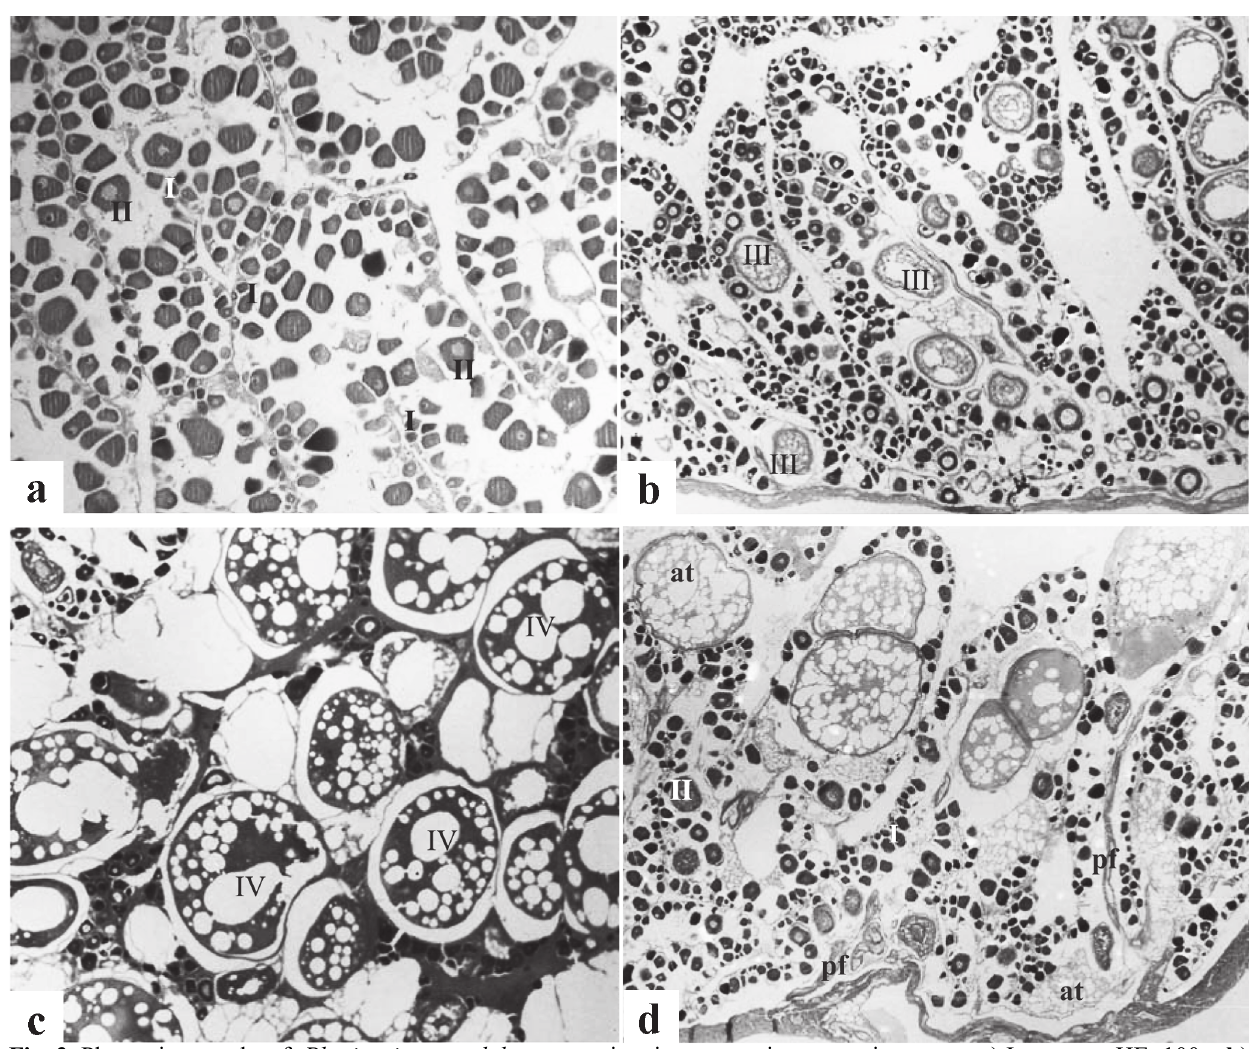
Fig. 3. Photomicrographs of Plagioscion magdalenae ovarian tissue at various maturity stages. a ) Immature, HE, 100x. b ) Maturing, HE, 100x. c ) Mature, HE, 40x. d ) Spawned/spent, HE, 40x. I. chromatin nucleolus (stage I); II. perinucleolar stage (stage II); III. cortical alveoli oocytes (stage III); IV. full vitellogenic (stage IV); pf. postovulatory follicles; at. atretic